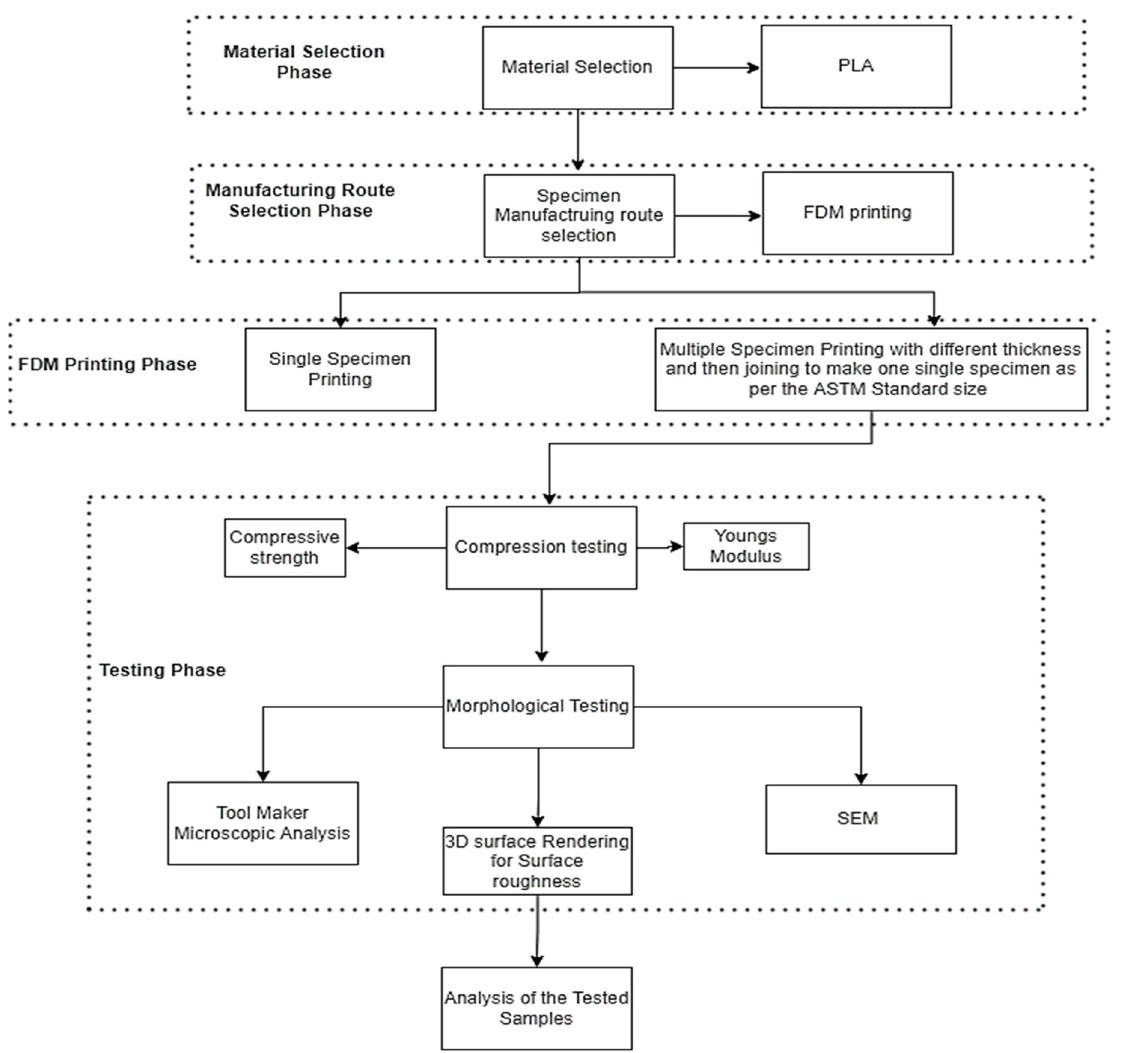
Figure 4. Our methodology for exploring the mechanical and morphological characteristics of 3D printed PLA.